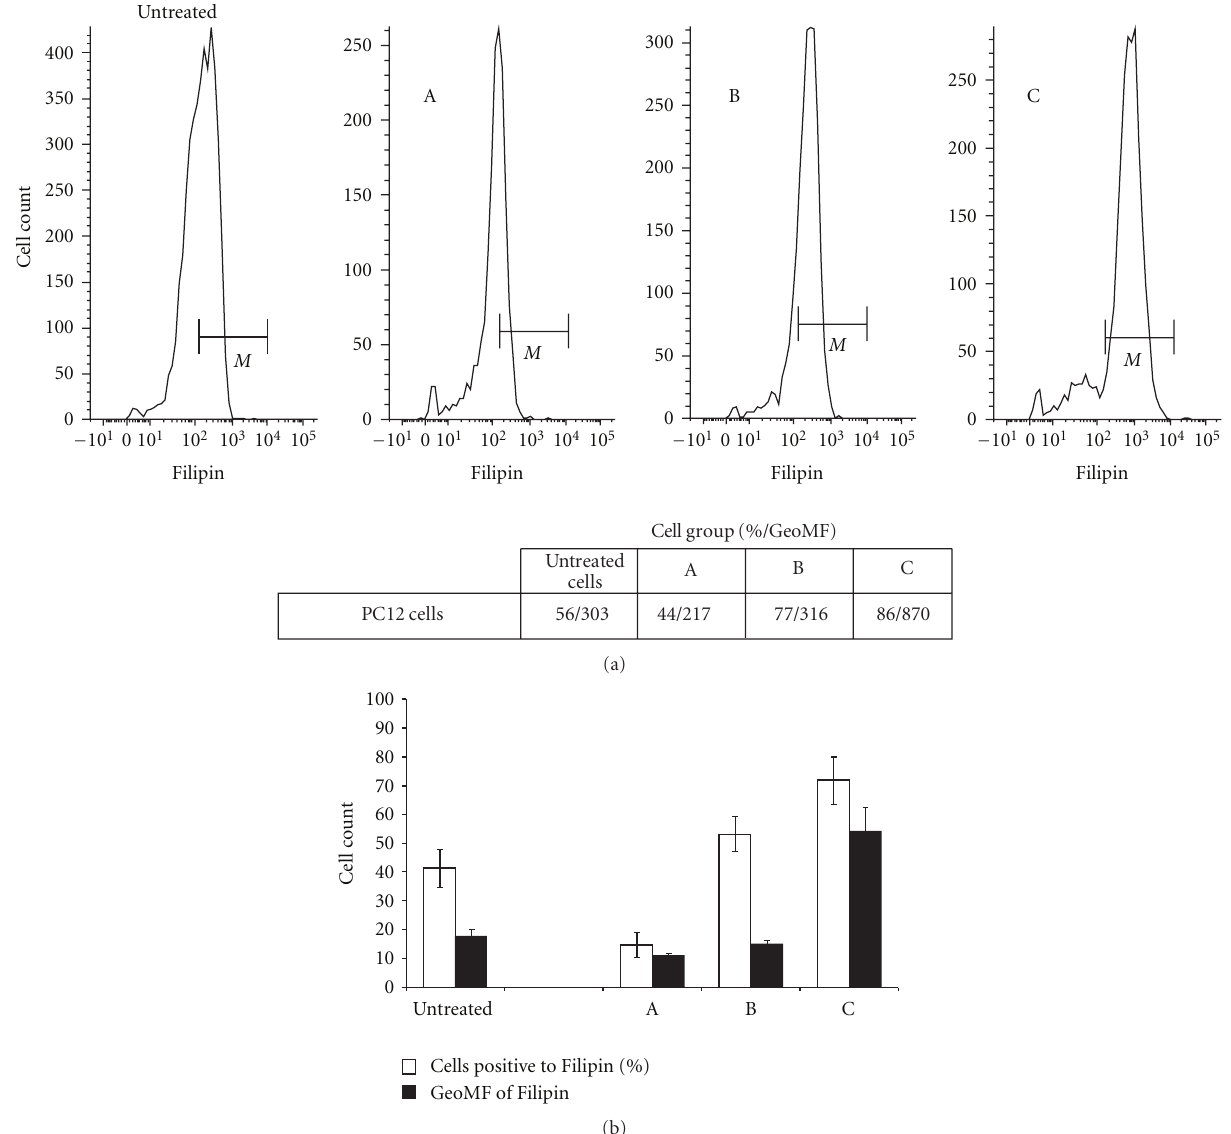
Figure 5: Correlation between the levels of cholesterol in the membrane and the binding of A β -FAM to the membrane surface. PC12 cells were exposed for 80 minutes to A β 42-FAM, washed to remove unbound A β -FAM, and then incubated for 40 minutes in PBS containing Filipin III. (a) shows the flow cytometric analysis of the cholesterol content of the three subpopulations of cells distinguished on the bases of the level of A β -FAM binding. The percentage of cells and the Geo mean of fluorescence (GeoMF) values measured within the M gate are displayed in the bottom table. The highest level of filipin III fluorescence is observed in the cells from the subpopulation C, defined as extra high A β -FAM a ffi nity. The bars plot in (b) summarizes the percentage of cells and the GMF values within gate M corresponding to each subpopulation of data pooled from four